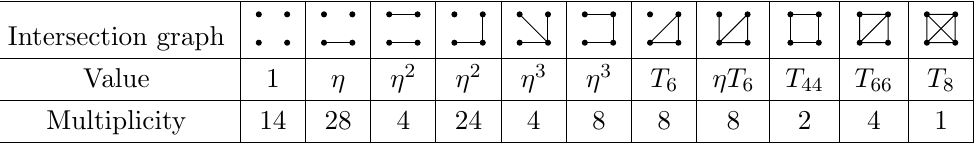
Table 2 . All the intersection graphs contributing to the eighth